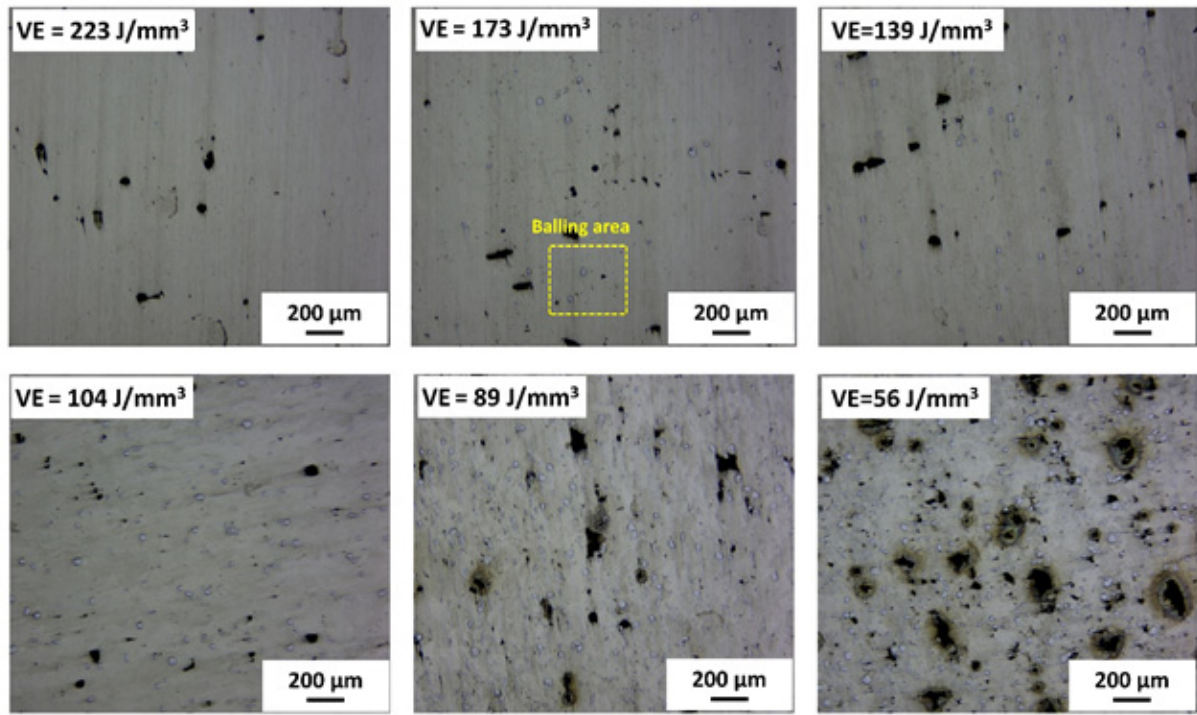
Figure 5. Metallographic images (50 × ) of XY surface (perpendicular to the printing direction) of as-printed samples fabricated via elemental powder blend.